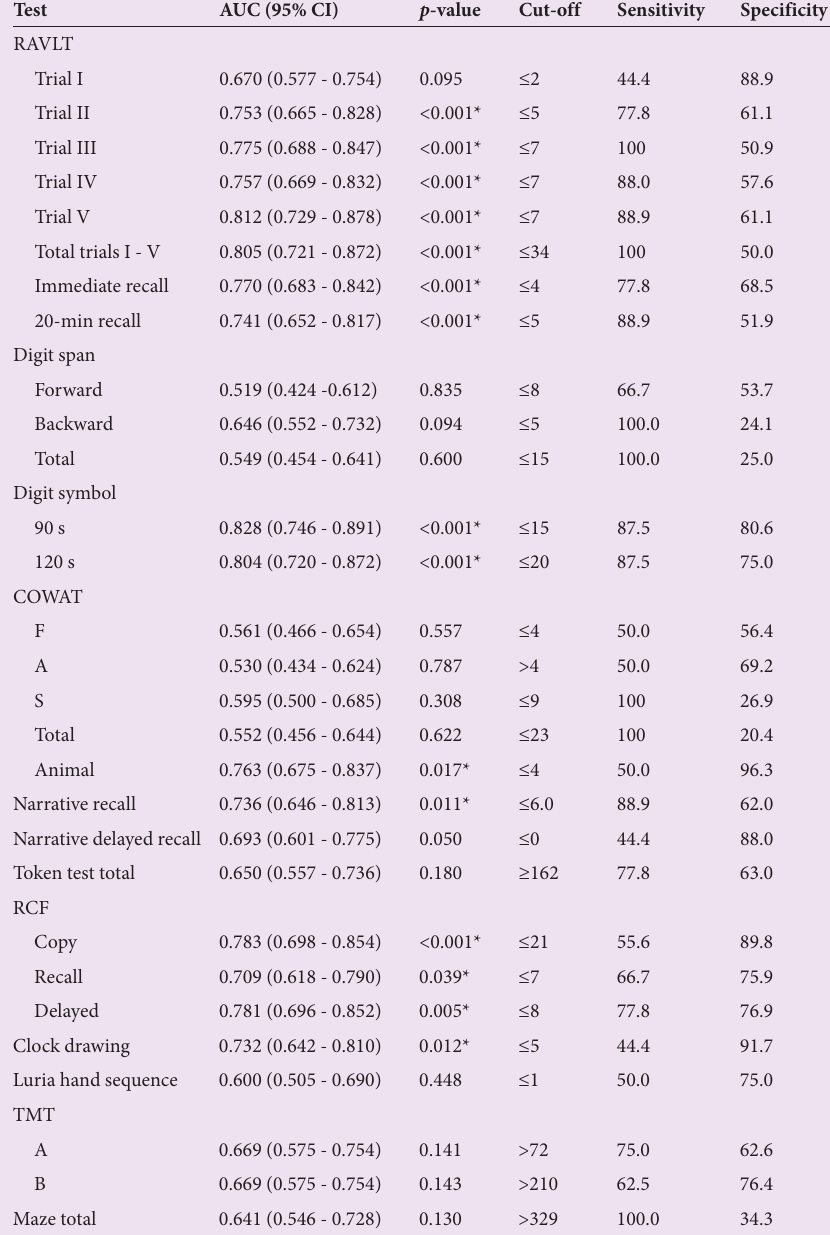
ROC = random operating curve; AUC = area under the curve; CI = confidence interval; RAVLT = Rey auditory verbal learning test; COWAT = controlled oral word association test; RCF = Rey complex figure; TMT = trail making test. *Significance level set as p <0.05 and 95%